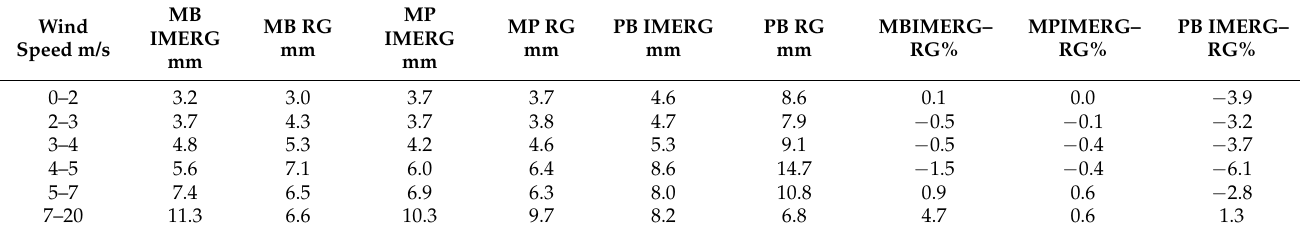
Table 4. Average annual difference (2010–2020) between snow level water equivalents (SLWE) and IMERG data and average annual difference (2010–2020) between SLWE and rain gauges data (RG); the values are given in mm (MB mm; MP mm; PB mm) and as a percentage of the annual average rainfall 2010–2020 (MB%; MP%; PB%). Wind Speed